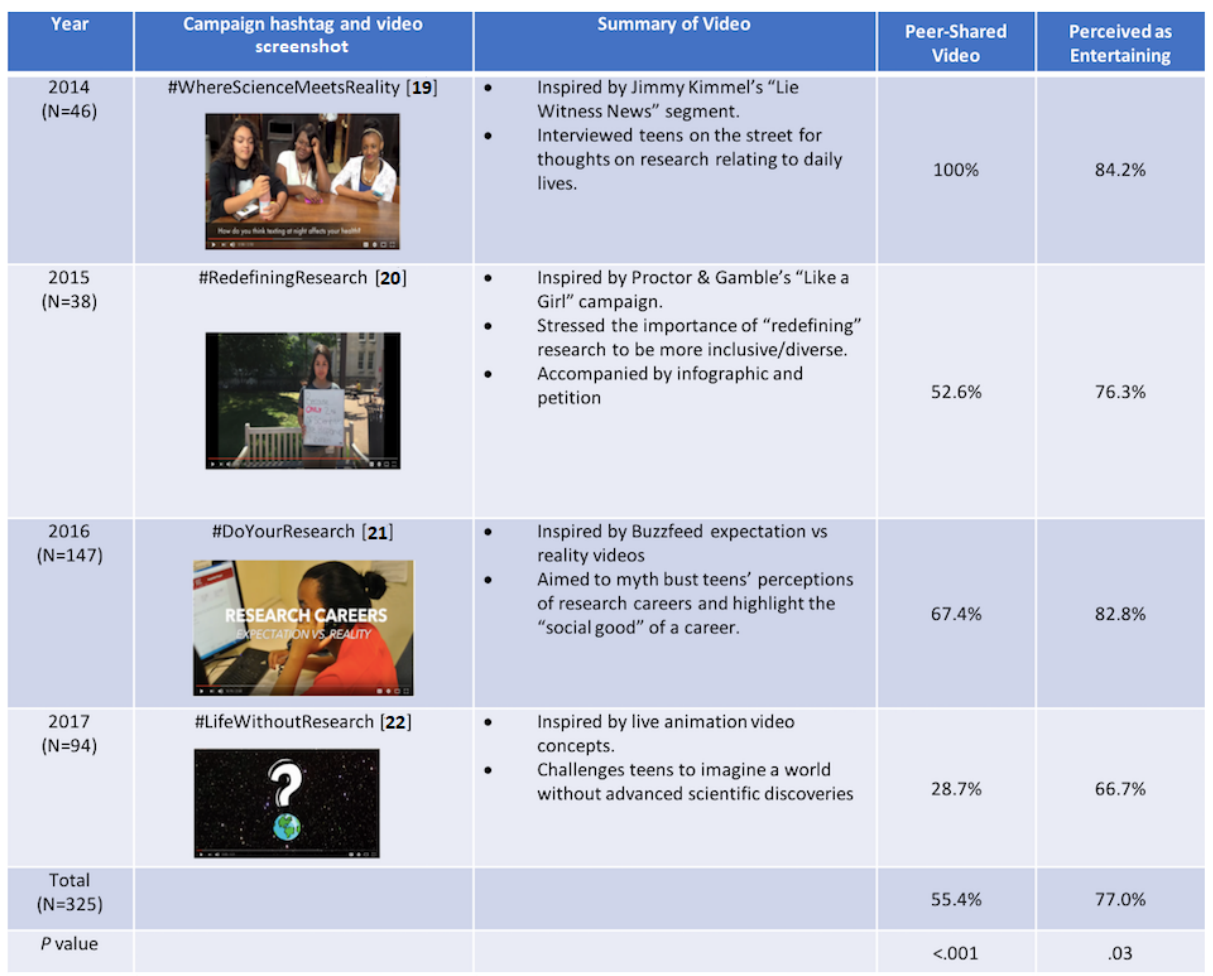
Figure 1. Spreading Teen Research Inspired Videos to Engage Schoolmates (STRIVES) video topics and summaries by year [19-22], including the percentage of subjects who watched the video through peer-disseminated sources during the social media campaign rather than through a link on the post-campaign Career Orientation Survey and the percentage of subjects who responded “agree” or “strongly agree” to the Likert-style question “I found the video entertaining” in the postcampaign Career Orientation Survey. P values were generated through Chi square analysis in STATA